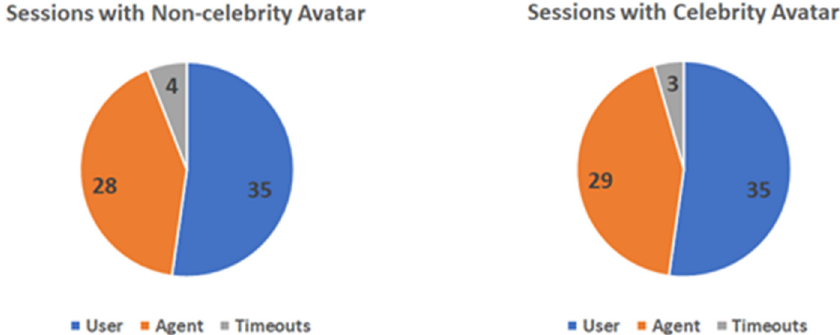
Figure 6. Number of Agreements in Each Negotiation Setting.